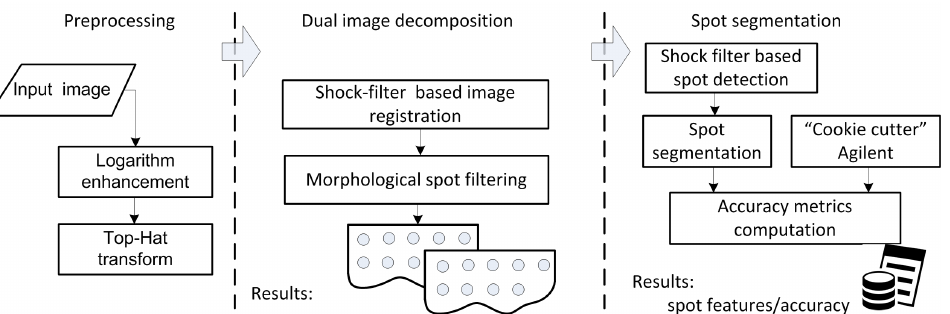
Figure 1. Image-processing workflow for hexagonal-grid-layout image registration and